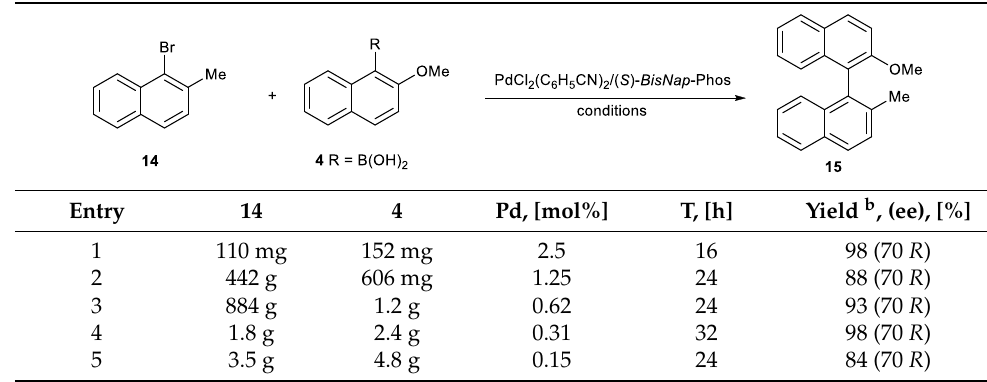
Table 11. Effect of catalyst amount in asymmetric synthesis of 15 a .